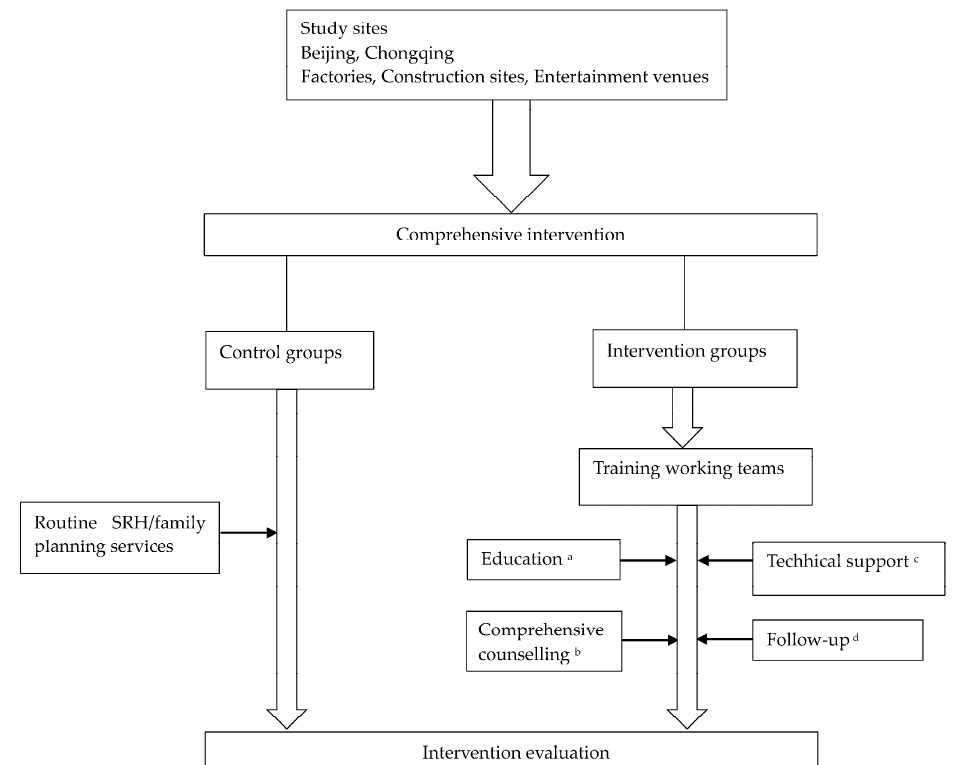
Figure 1. Implementation of the comprehensive intervention in the two cities.